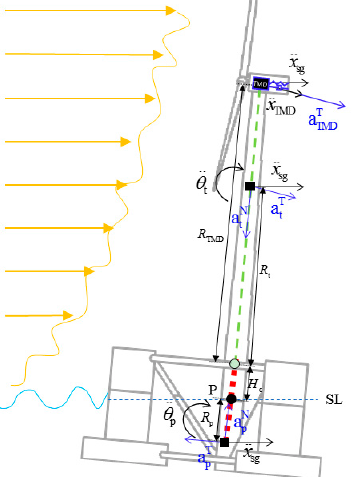
Figure 2. Schematic of the OC4-DeepCwind simplified dynamic